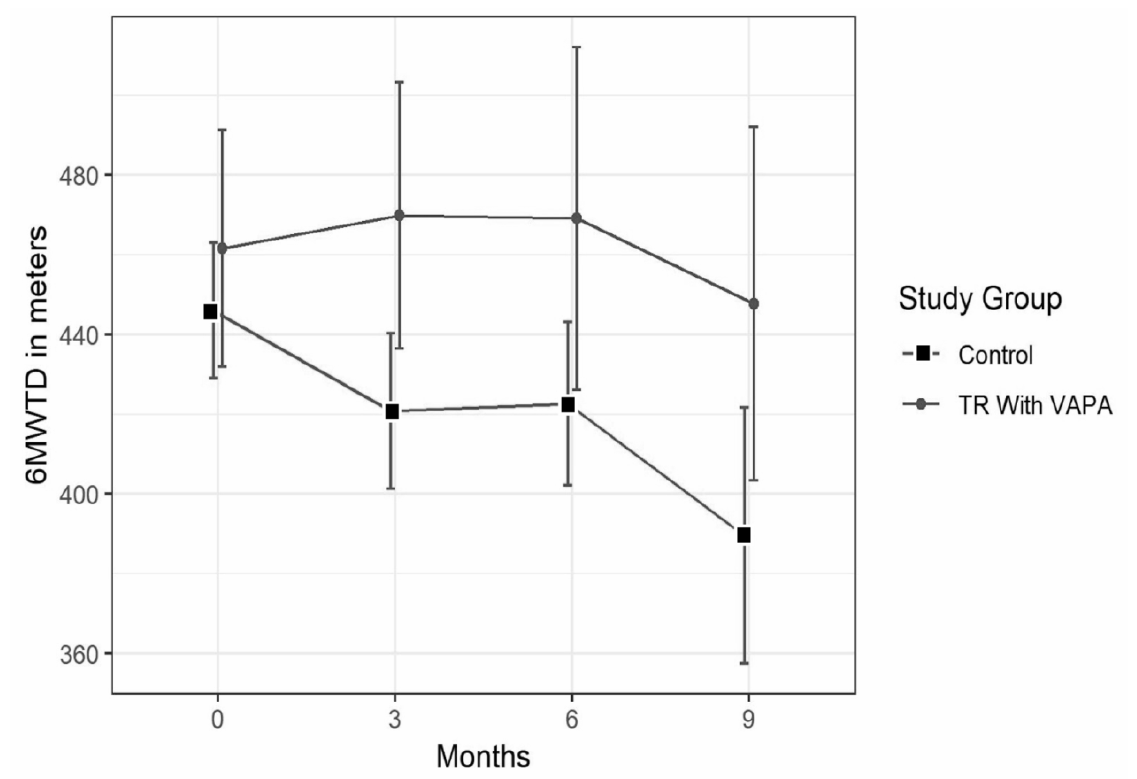
Figure 3. Six-minute walk test distance (6MWTD) in the tele-rehabilitation with VAPA group and the control group. Data are displayed as the mean difference in meters and standard deviations.